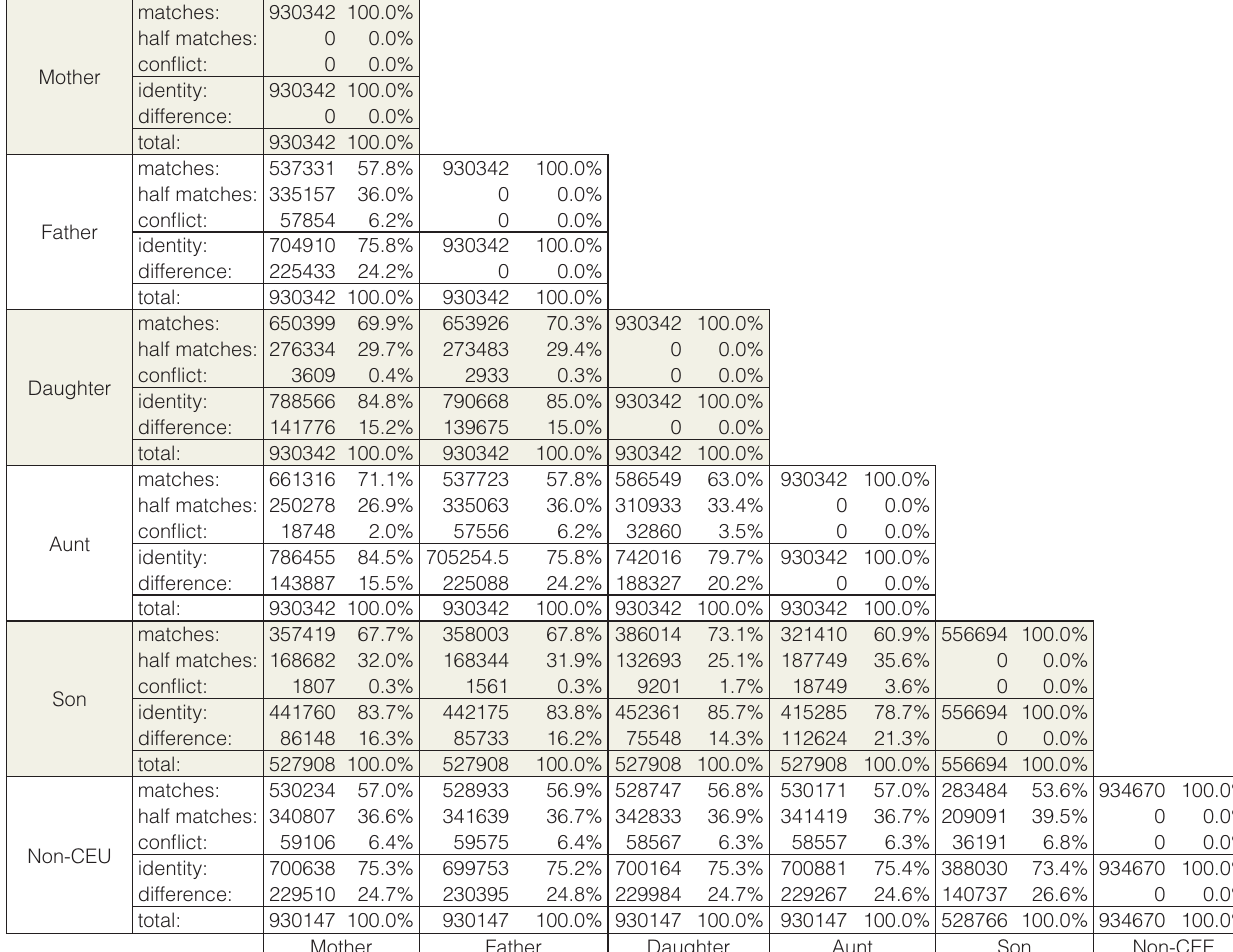
Table 6. Similarity comparison of all-against-all family genotypes plus a non-European (non-CEU) male of Indian ethnic background. Matches denote identical genotypes for the same SNP (e.g. AA/AA); half-match, only one of the alleles is identical (e.g. AT/AA) and conflict means both alleles are different (e.g.